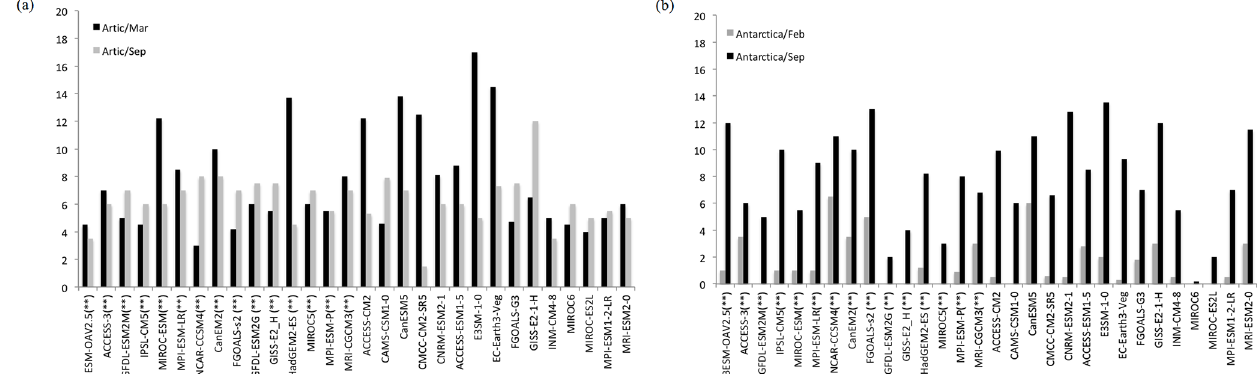
Figure 6. Climatology of maximum and minimum sea ice area (million square kilometers) for the last 30 years of the Abrupt-4 × CO 2 numerical experiment minus the last 30 years of the piControl run for the CMIP5 and CMIP6 models. (a) Arctic: black colors represent March and gray colors represent September; (b) Antarctic: black colors represent September and gray colors represent